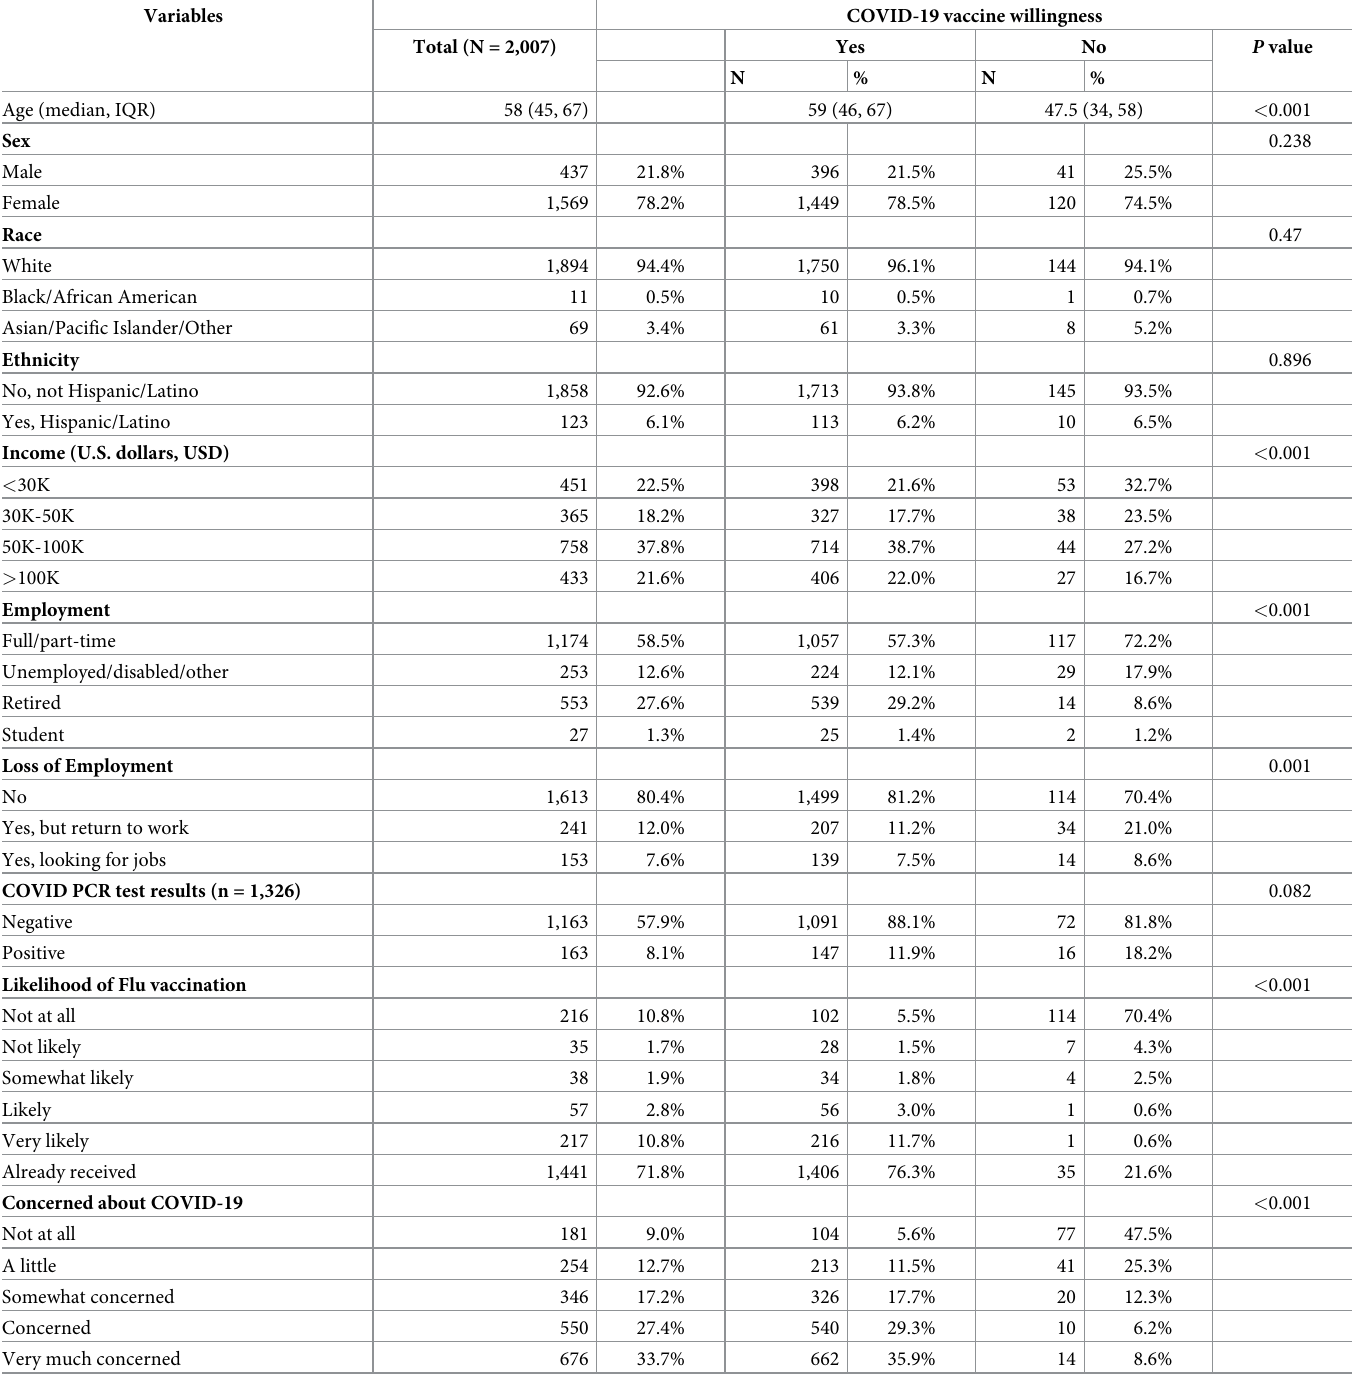
Table 1. Sample characteristics by COVID-19 vaccine